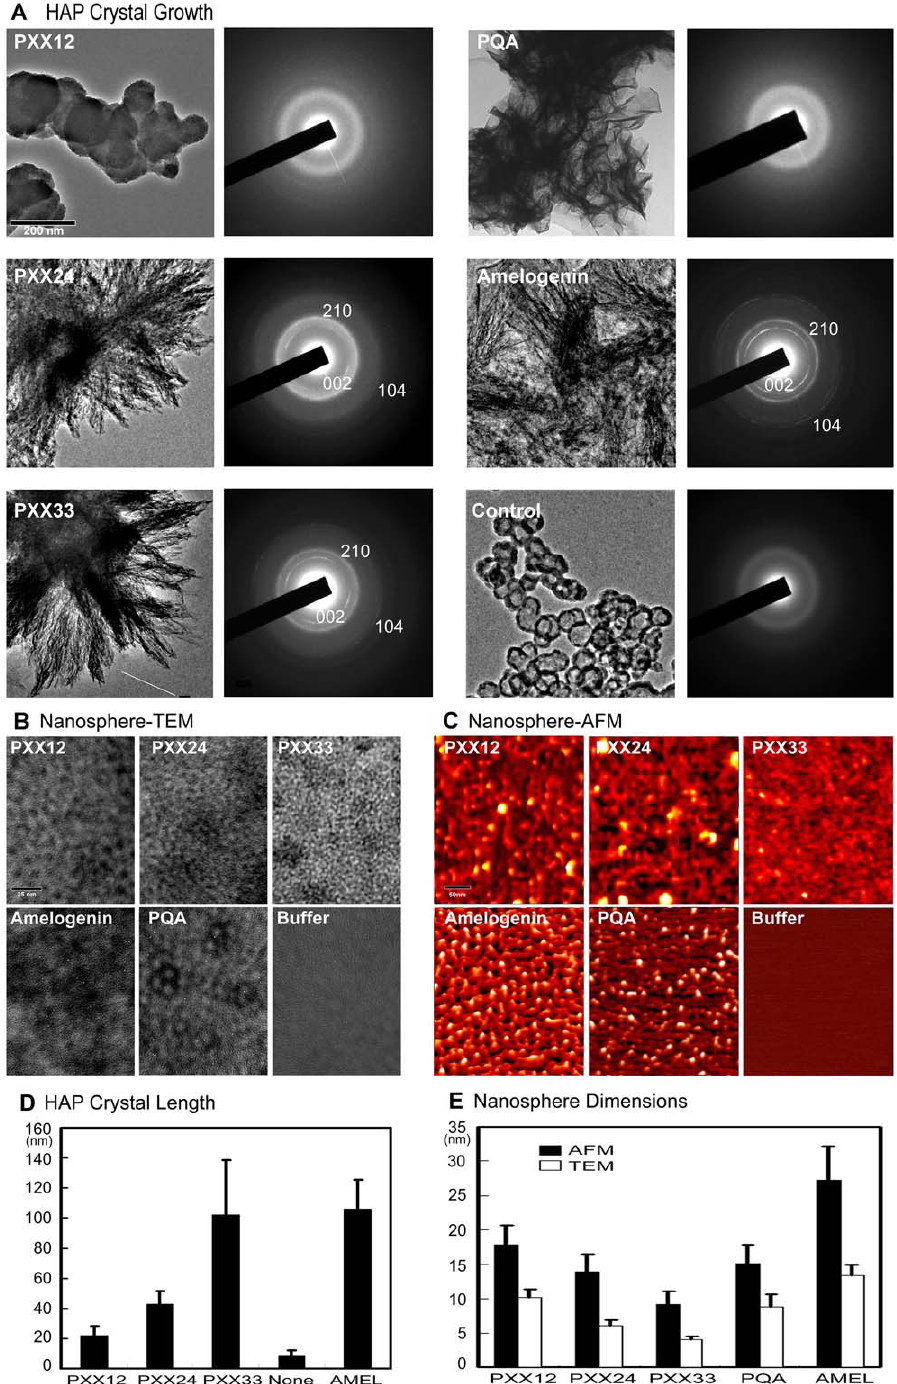
Figure 2. Hydroxyapatite crystal growth control and self-assembly of polyproline designer peptides. (A and D) Effect of polyproline designer peptides on hydroxyapatite (HAP) crystal growth. Increasing length of designer peptides from PXX12 to PXX33 resulted in elongated HAP crystal (A). HAP crystals grown with PXX33 were similar in length to those grown with full-length amelogenin. The PQA glutamine/alanine replacement peptide resulted in thin plates unlike the needles grown with PXX repeat peptides. HAP control solutions incubated without protein formed spherical deposits. Crystal dimensions are documented in (D). Bar=200 nm. Electron diffraction analysis of PXX24, PXX33, and amelogenin treated samples resulted in sharp and distinct reflection rings in the 002 and 210 planes and an additional faint ring in the 104 plane, similar to those found in developing enamel crystals. Control crystals and those grown in the presence of PXX12 and PQA only showed faint diffraction patterns. (B, C, and E) Effect of polyproline designer peptide length on supramolecular matrix assemblies. Both TEM and AFM analyses indicated that matrix subunit dimensions were significantly reduced with increasing designer peptide length (from PXX12 to PXX33). Full-length amelogenins formed sizable nanospheres measuring 27 nm by AFM and 13 nm by TEM in diameter. Matrix dimensions and assembly patterns of the PQA glutamine/alanine replacement peptide were significantly different from their PXX33 counterparts. Buffer control solutions did not assemble into nanosphere-like structures. All measurements in this study were statistically evaluated and displayed using standard deviation (s.d.). Bar (TEM)=25 nm, (AFM)=50 nm.